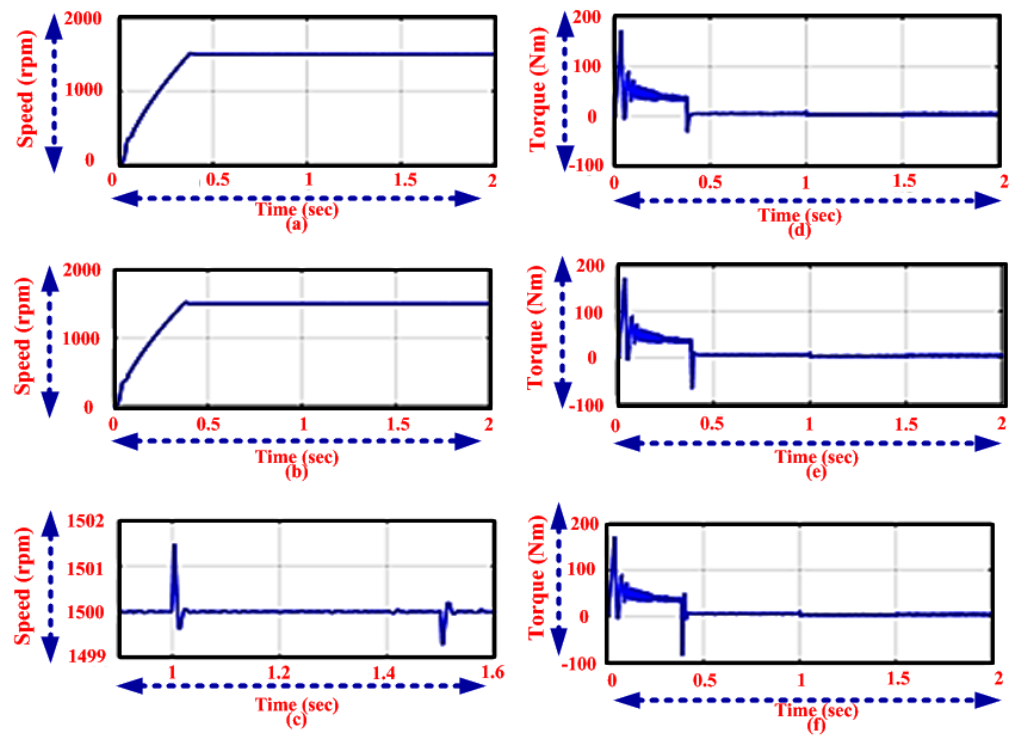
Figure 11. Analysis of Speed using the ( a ) proposed ( b ) MFO method and ( c ) PI controller and Torque using the ( d ) proposed ( e ) MFO method and ( f ) PI controller.